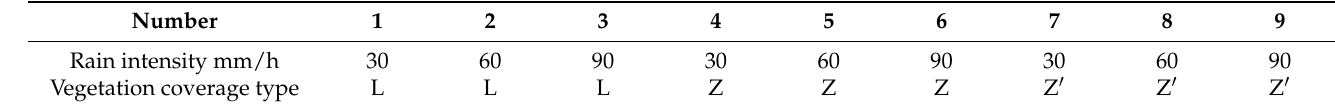
Table 1. The experimental